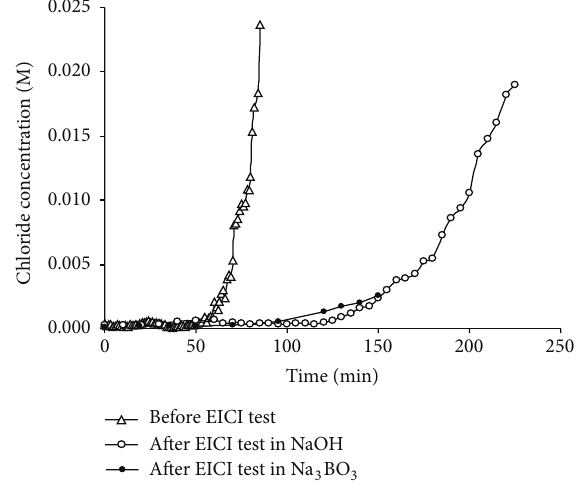
Figure 9: Evolution of chloride concentration in anolyte over time of electromigration test for mortar discs (with and without EICI treatment).